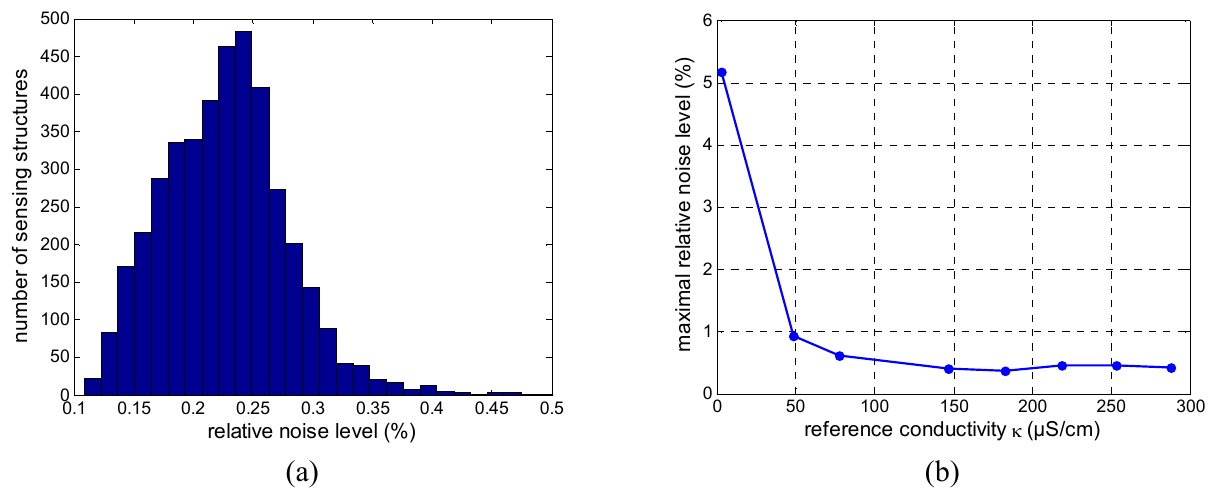
Figure 4 . (a) Exemplary relative noise level distribution for a reference conductivity value of 147 µS/cm. (b) Maximal relative noise level for several reference conductivity values κ